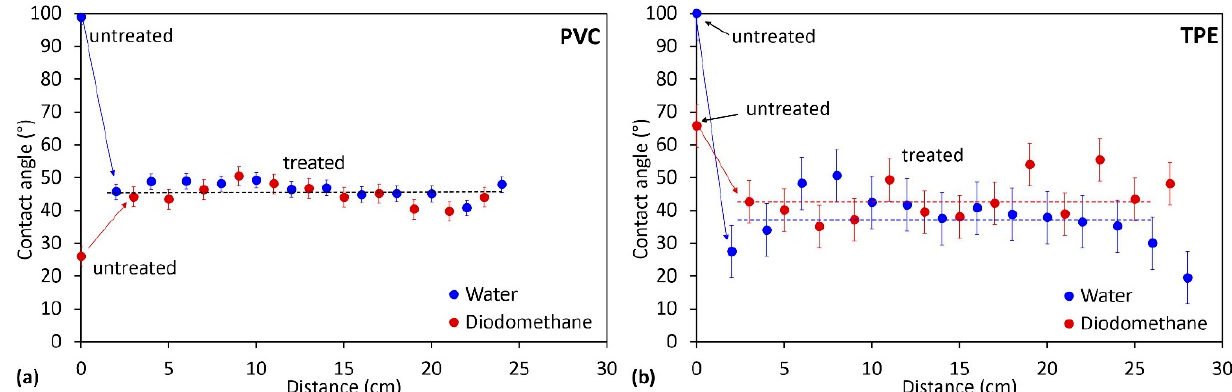
Figure 4. Contact angles of water and diodomethane droplets along the catheter tube: ( a ) PVC catheter and ( b ) TPE catheter. Zero on the x-axis corresponds to the end of the catheter tube which is closer to the coil (see Figure 5). Contact angles for untreated samples are added.